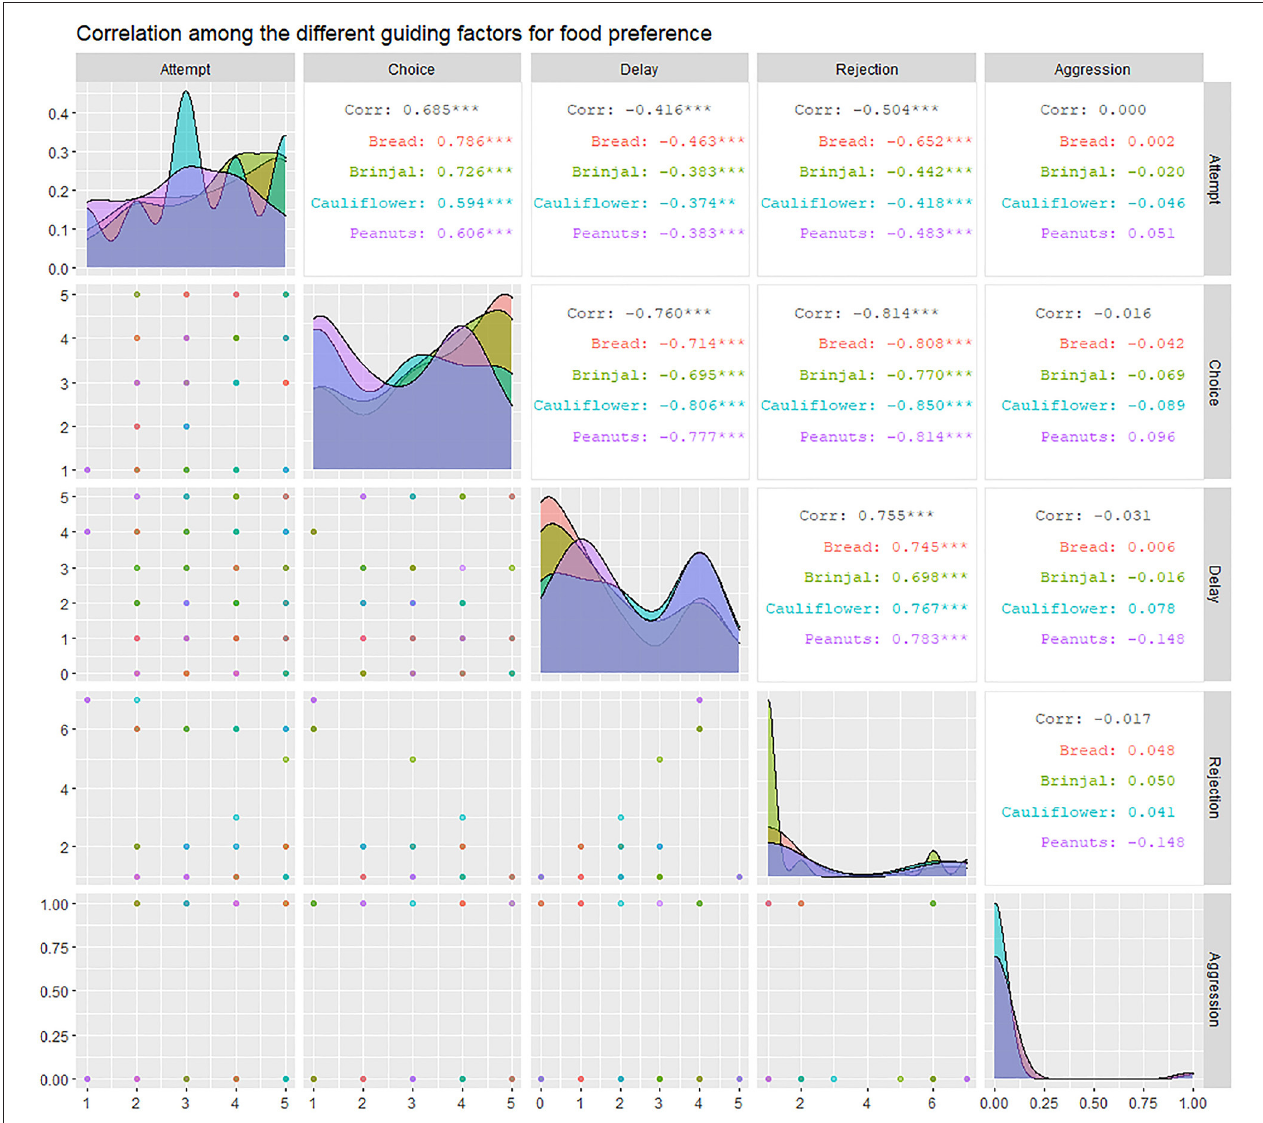
FIGURE 5 | The correlogram representing the inter-relation between factors like “attempt” (FA), “choice” (FC), “rejection” (RJ), “aggression” (AG), and “delay.” It provides the correlation coefficient values ( r ) for each combination of factors and separately for each of the four food items along with their level of significance.